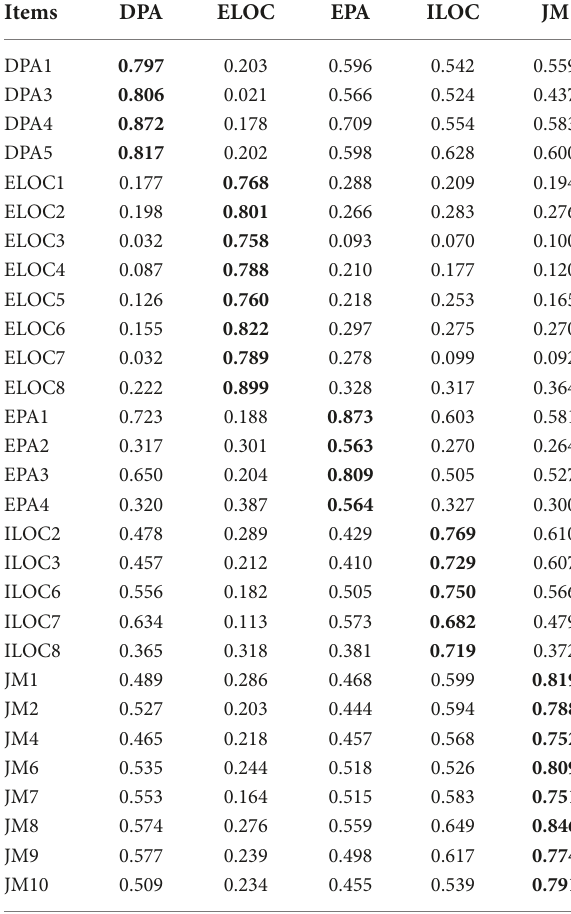
TABLE 5 Items loading, composite reliability (CR), and convergent validity